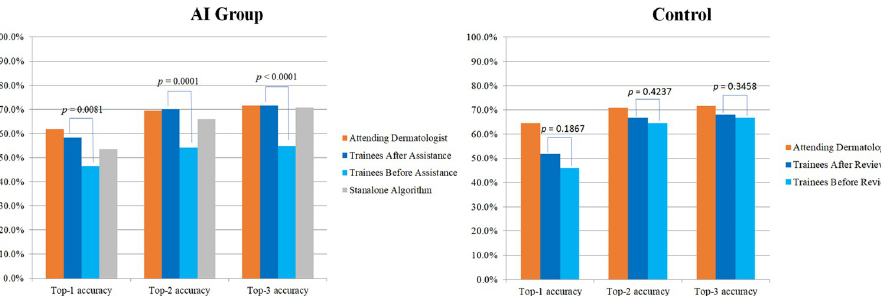
Fig 2. Top accuracies for diagnosing exact diseases. The physicians of the AI group ( n = 144) referred to the three predictions of the algorithm’s diagnoses and the malignancy score before modifying their first impressions. The physicians of the Control group ( n = 141) just reviewed the photographs once again. The P -values of top accuracies between before and after assistance of the trainees are annotated.